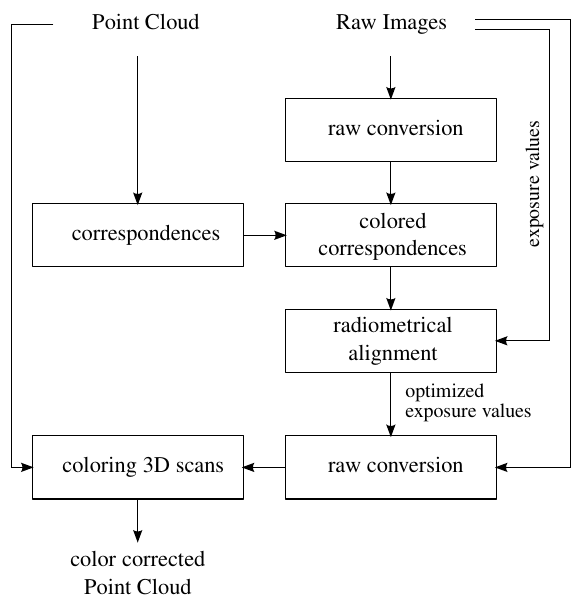
Figure 4. framework for radiometrical aligning point clouds Equation 6 then